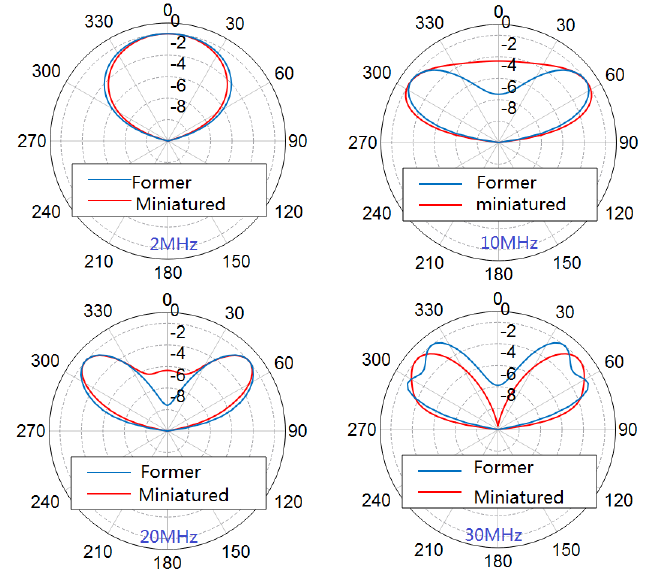
Figure 8. Directivity pattern comparison.